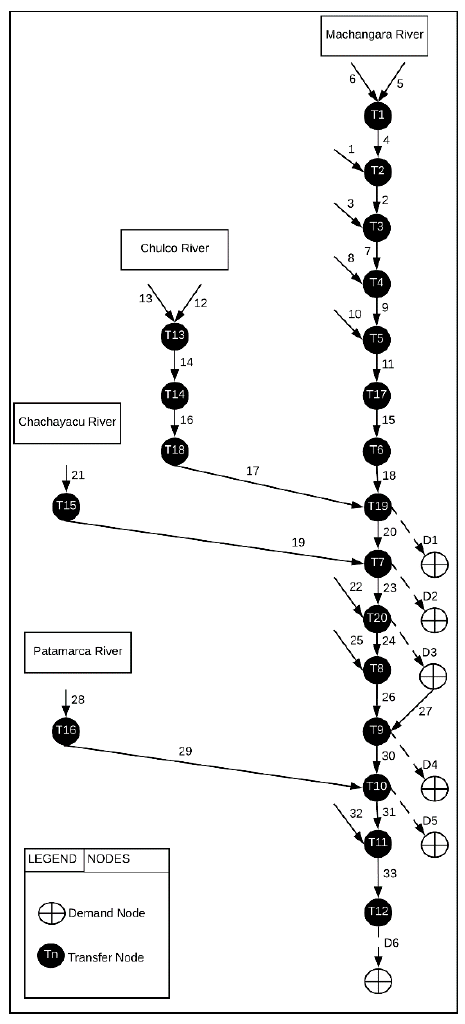
Figure 8. The final network configuration of the Machángara River system as to the MILP model.